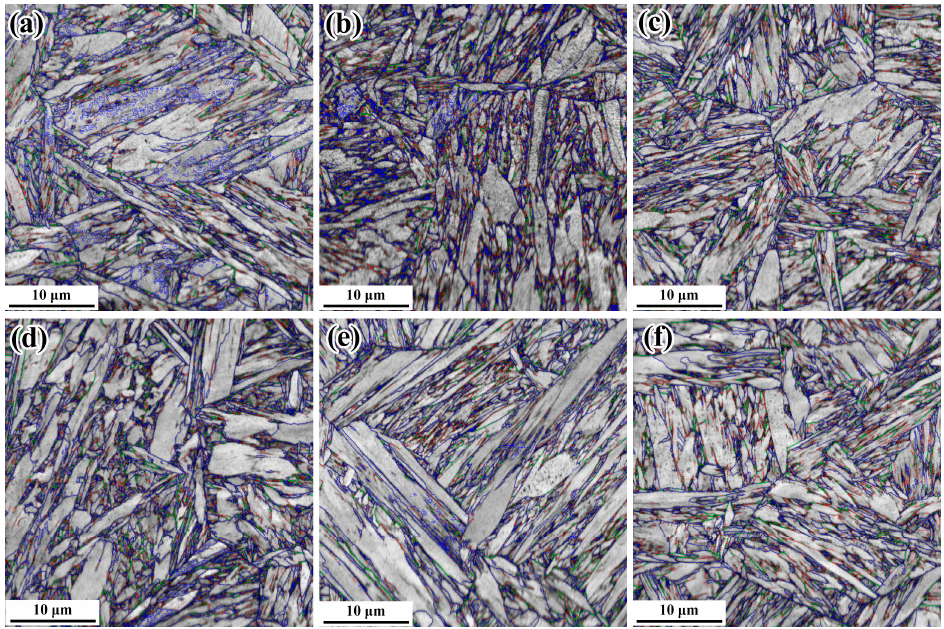
Figure 6. The grain boundaries of samples at the positions of 5 mm and 15 mm below rail tread treated by di ff erent process: ( a ) T230-P5; ( b ) T250-P5; ( c ) T280-P5; ( d ) T230-P15; ( e ) T250-P15; ( f ) T280-P15.